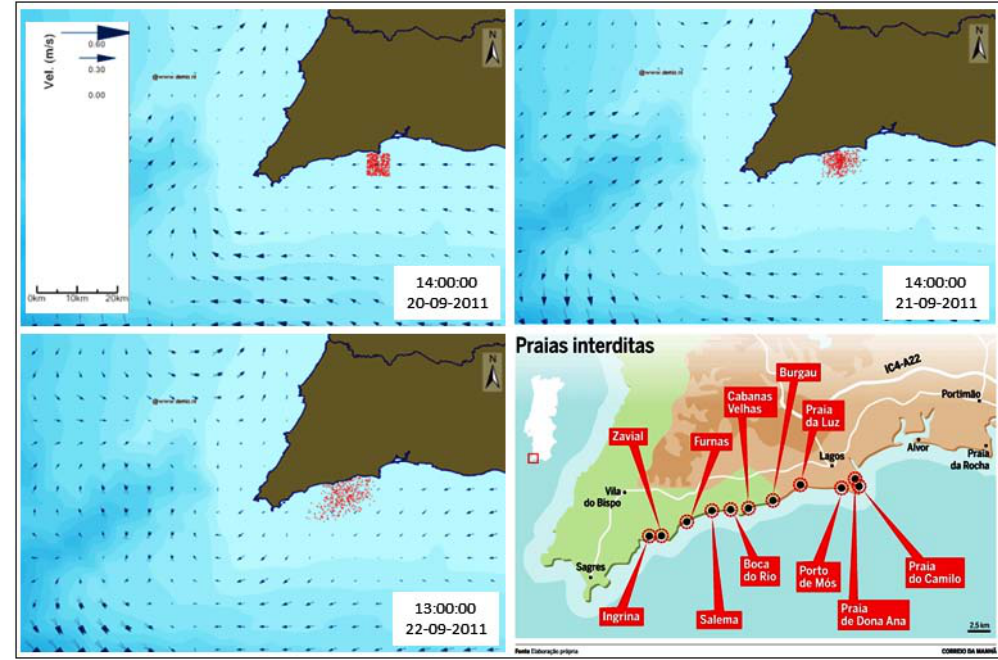
Fig. 13. MOHID-PCOMS forecast for potential impacted areas by the tracking of Ostreopsis cf. ovata bloom position. The forecast was used for the decision-making process, leading to the closure of several beaches in a major tourist spots in Portugal (panel in the lower-right side; image retrieved from a national